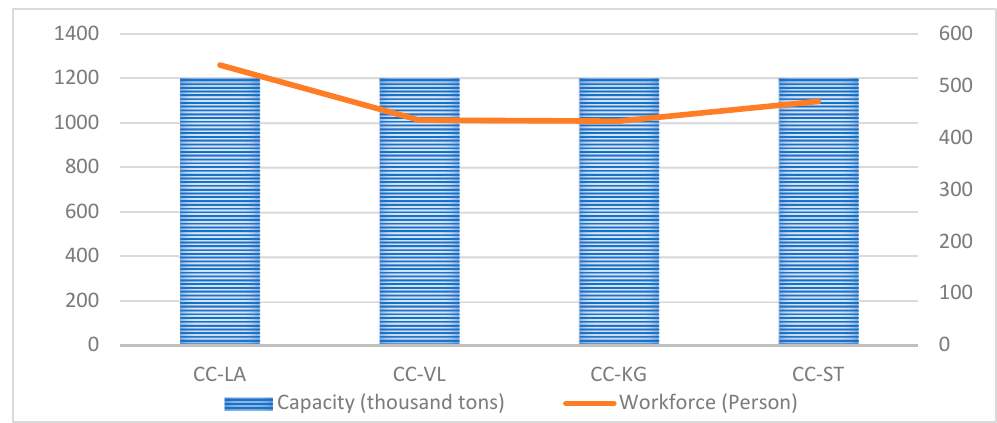
Figure 5. Crossdocking center location, scale, and workforce level.